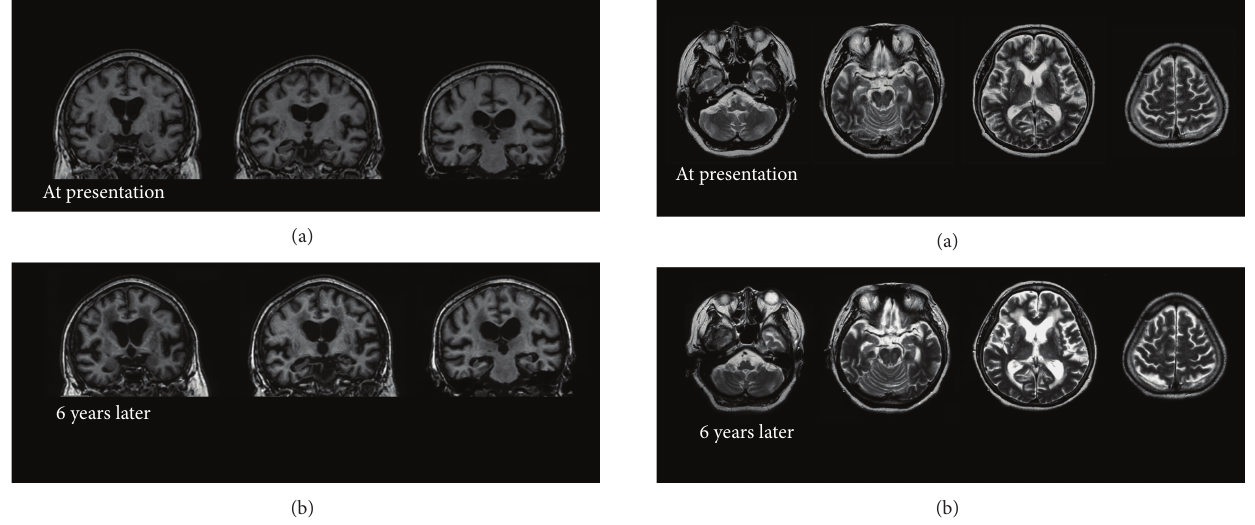
Figure 4: Coronal T1 weighted brain Magnetic Resonance Image (MRI) of the patient in Case B at presentation (a) and 6 years later (b). No mass signs were observed. Low signal intensity in the periventricular white matter suggesting leukoaraiosis was observed at presentation and progressed in 6 years. Diffuse cerebral and hippocampal atrophy, as well as enlargement of the lateral ventricles, which advanced in 6 years, was consistent with comorbid Alzheimer’s disease.